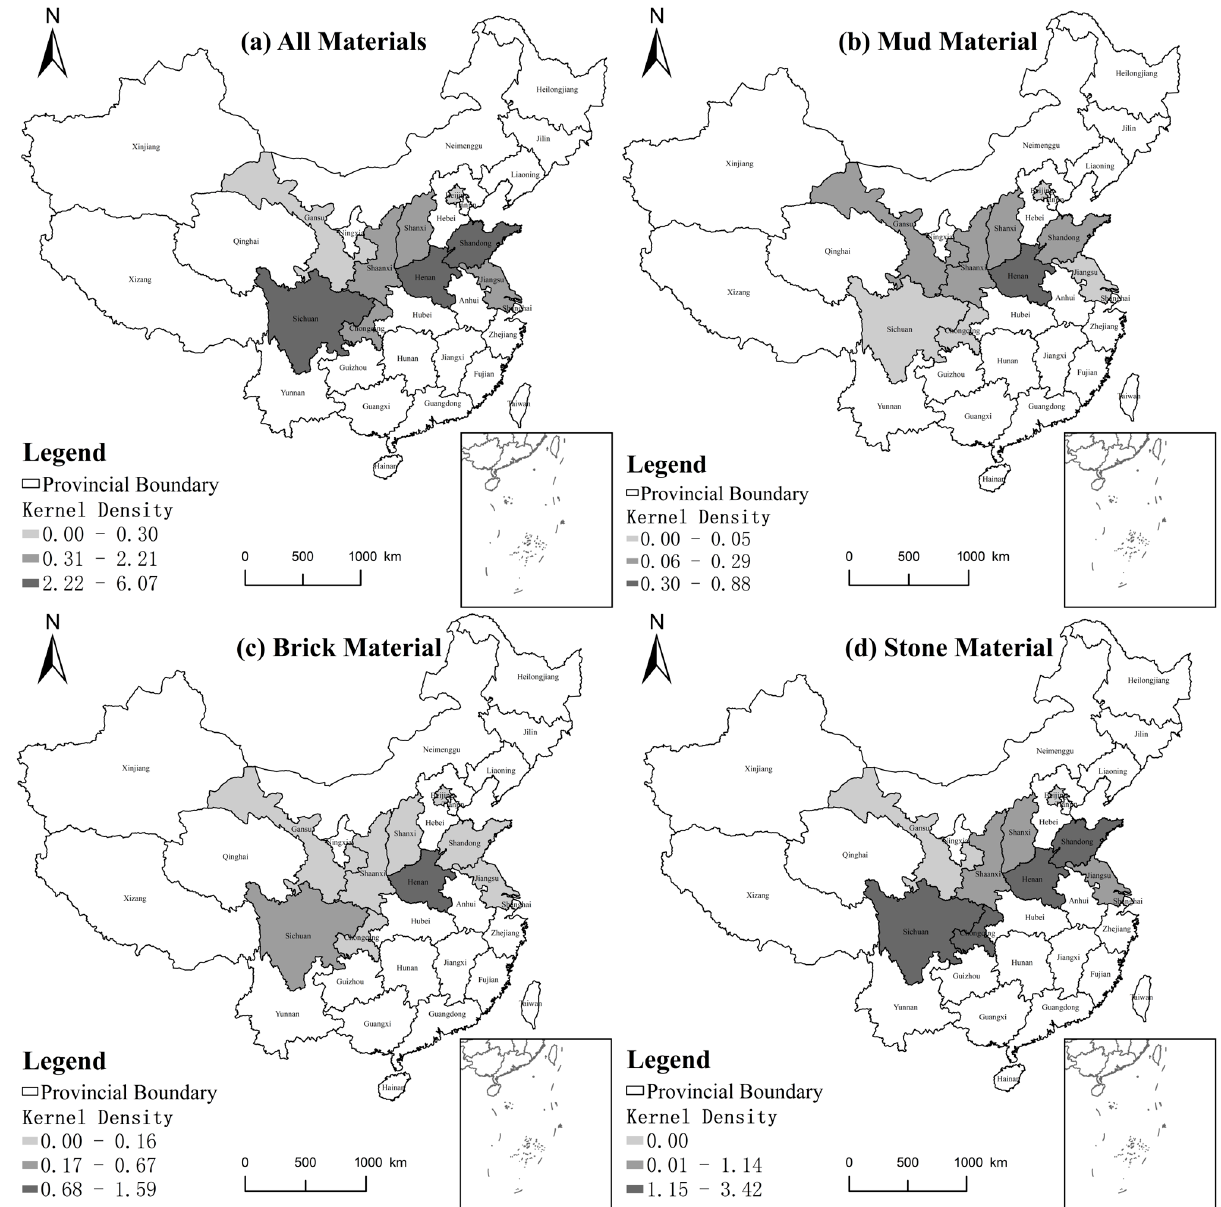
Figure 5. Kernel density distribution map of the types of Han Dynasty relic sites.